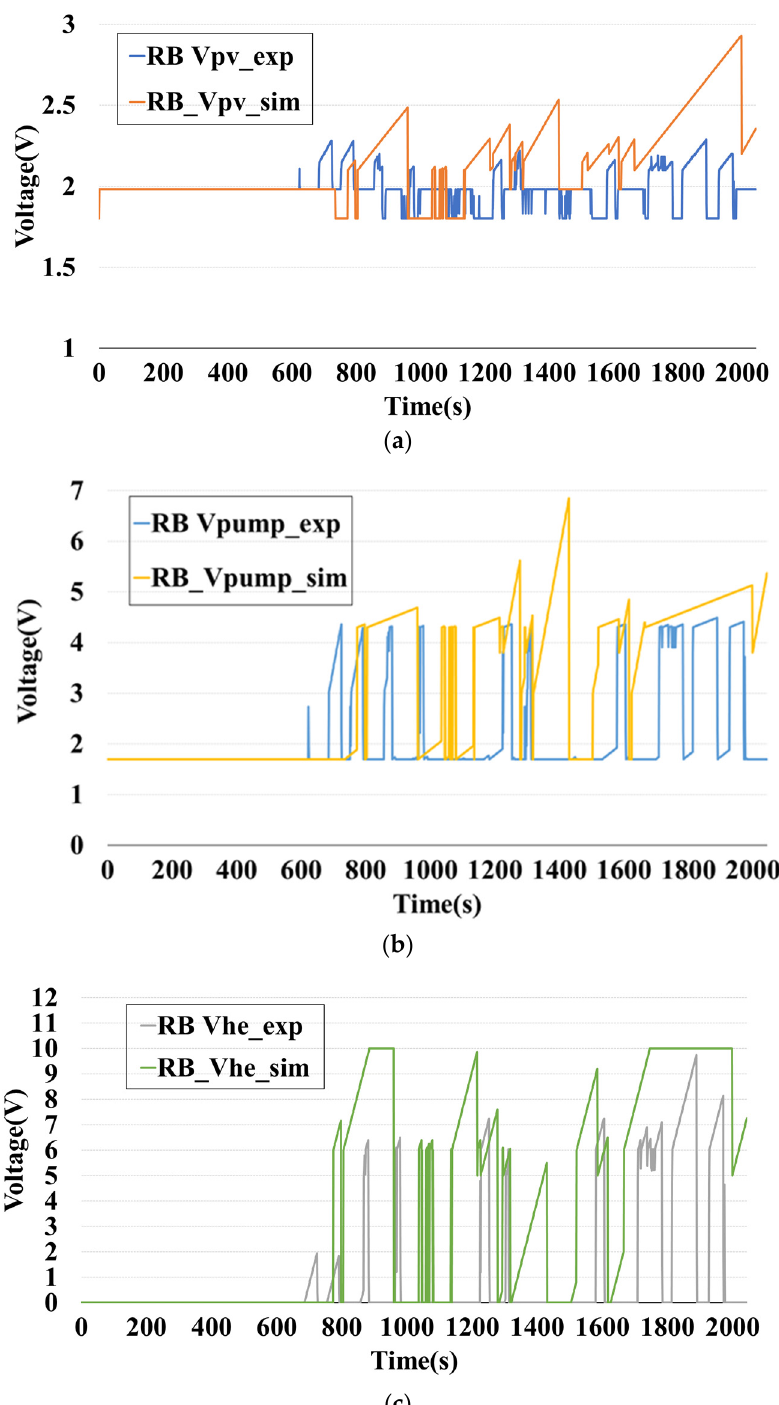
Figure 11. Simulation/experiment comparison of the control signals of key components: ( a ) propor- tional valve voltage; ( b ) coolant pump voltage; ( c ) radiator voltage.